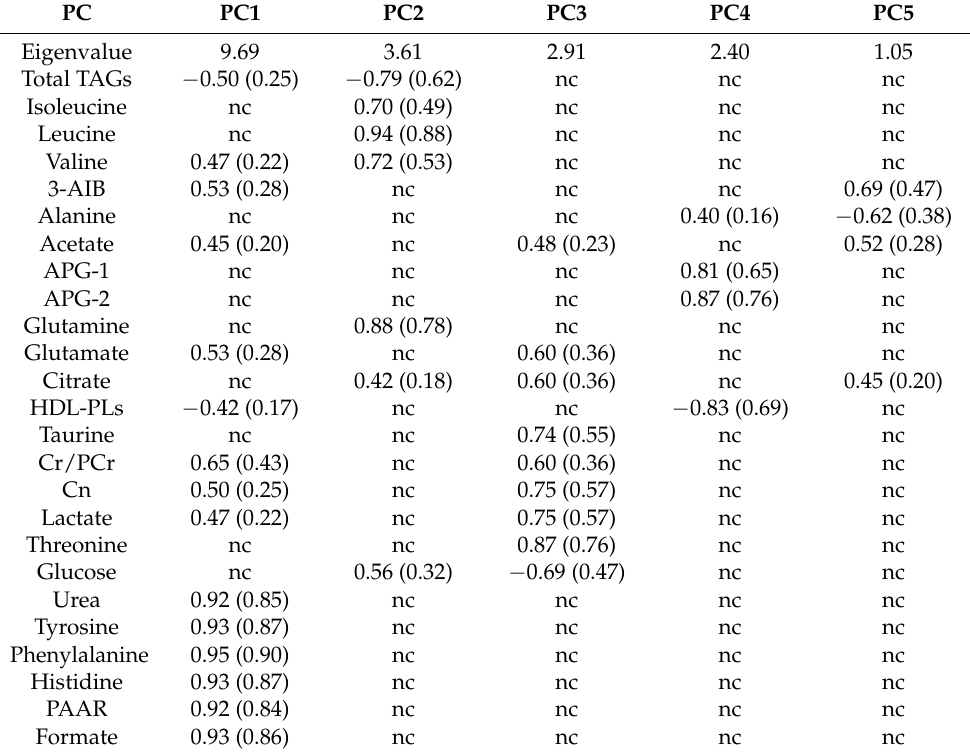
Table 4. Loadings vectors of metabolites showing their significant contributions towards PCs 1–5 for the Model 2 dataset (corresponding squared cosine values in brackets). Biomolecular predictors with loadings vectors of magnitudes within the ± 0.40 range were not considered (nc), since they are only included as significant contributors if they lie outside it